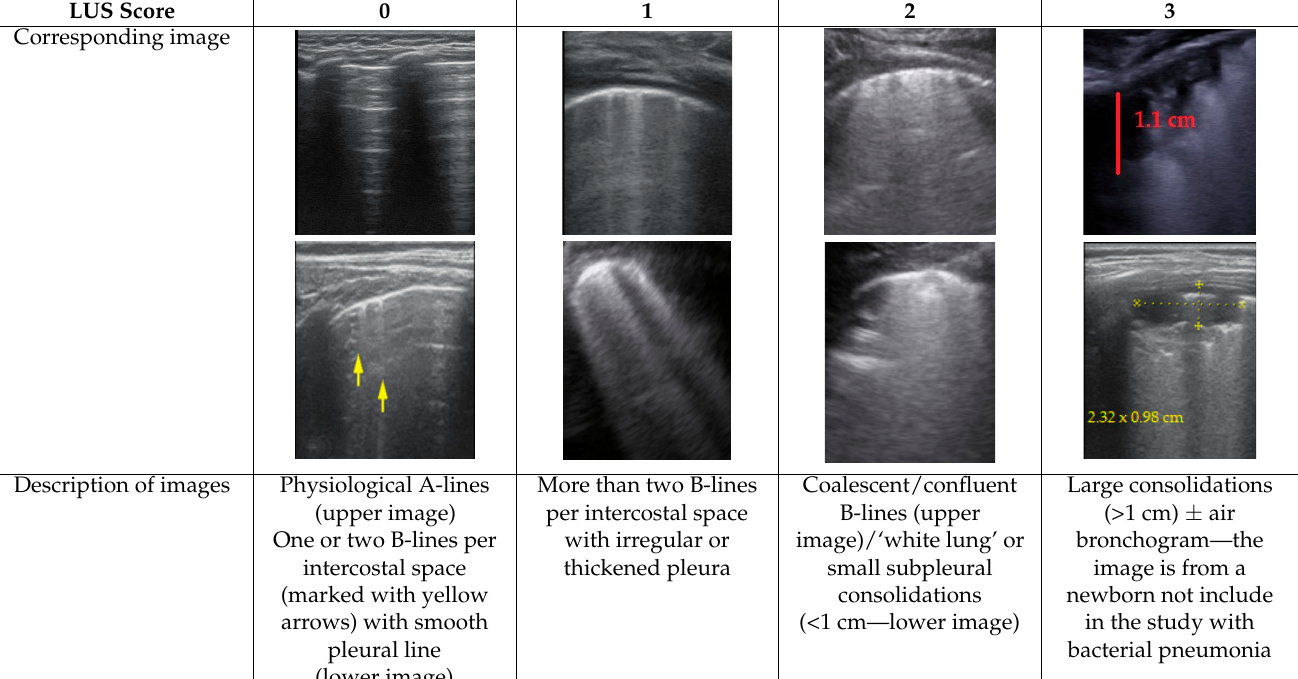
Figure 2. Lung areas—anatomical representation with 12 zones (AAL—anterior axillary line, PAL—posterior axillary line). Table 1. LUS score, corresponding image, and description of image. LUS score Corresponding image